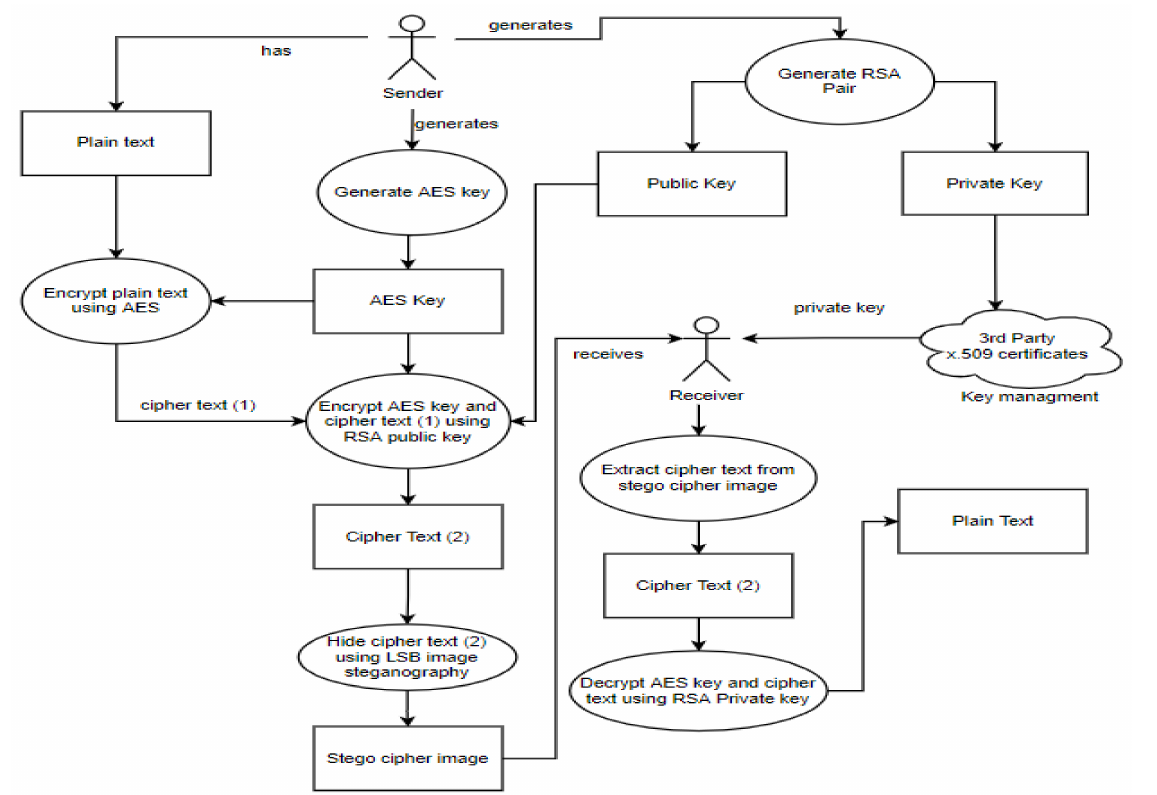
Figure 2. A description of how the LSB steganography works in the security